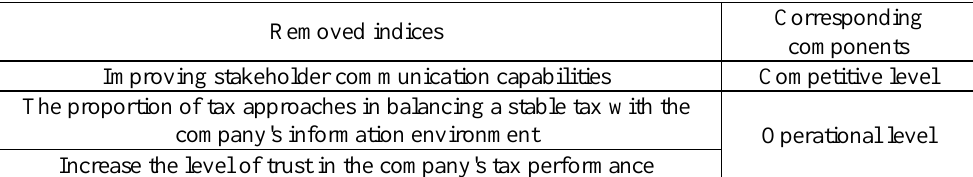
Table 6. First-round Delphi's removed and integrated